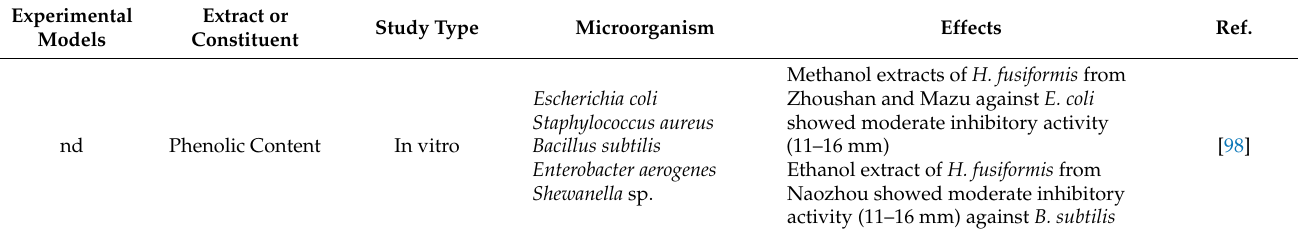
Table 5. Summary of the antibacterial activity of H. fusiformis . Experimental